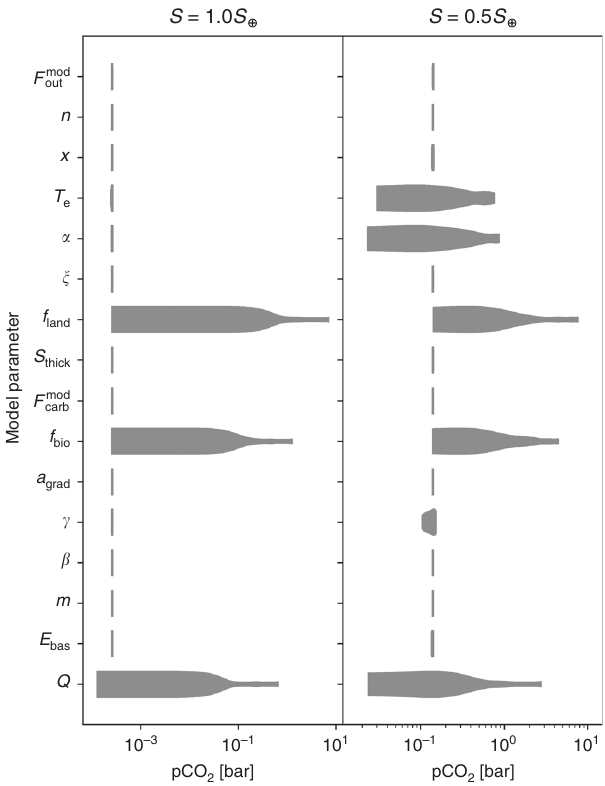
Fig. 5 The spread in steady-state pCO 2 from varying a single model parameter. Each parameter in Table 1 is shown on the vertical axis (note that n out and τ are incorporated into Q , see Eq. (10)). The left panel shows an incident fl ux of S = 1.0 S ⊕ . The right panel shows an incident fl ux of S = 0.5 S ⊕ . For each parameter, we held all other parameters constant at the modern Earth value (see text) and randomly sampled 100 values for the parameter in question from uniform distributions of the ranges given in Table 1. The horizontal extent of the gray shaded region shows the range of possible pCO 2 values when all other parameters are fi xed. The thickness of each gray shaded region shows the relative abundance of steady-state planets at that pCO 2 . The thickest regions show maximum relative abundance, the thinnest regions show the minimum relative abundance. No surface temperature limits on habitability were imposed for the simulated planets. At low pCO 2 , three parameters ( f land , f bio , and Q ) dominate the spread in pCO 2 . At higher pCO 2 , the temperature- and pCO 2 -dependence of continental silicate weathering ( T e and α ) are also important.